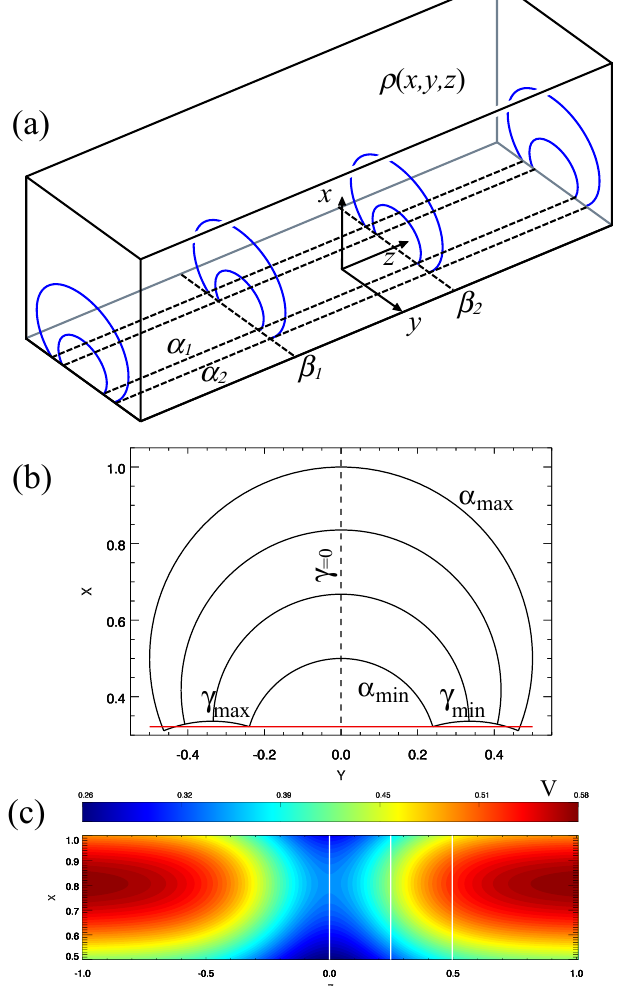
Figure 1. A sketch of the model field geometry. ( a ) A 3D (three-dimensional) view of the arcade based on a line dipole aligned with the z axis and sitting below the photosphere. The blue lines represent the portion of the magnetic field lines above the photosphere. ( b ) A cross-sectional view of the simulation domain and its boundaries in terms of field-aligned coordinates, α and γ (1). ( c ) The variation of Alfvén speed ( V ) in the vertical ( x , z ) plane (also the γ = 0 plane) that runs the length of the arcade. The vertical white lines indicate the z positions used to study the Alfvén wave fields displayed in Figure